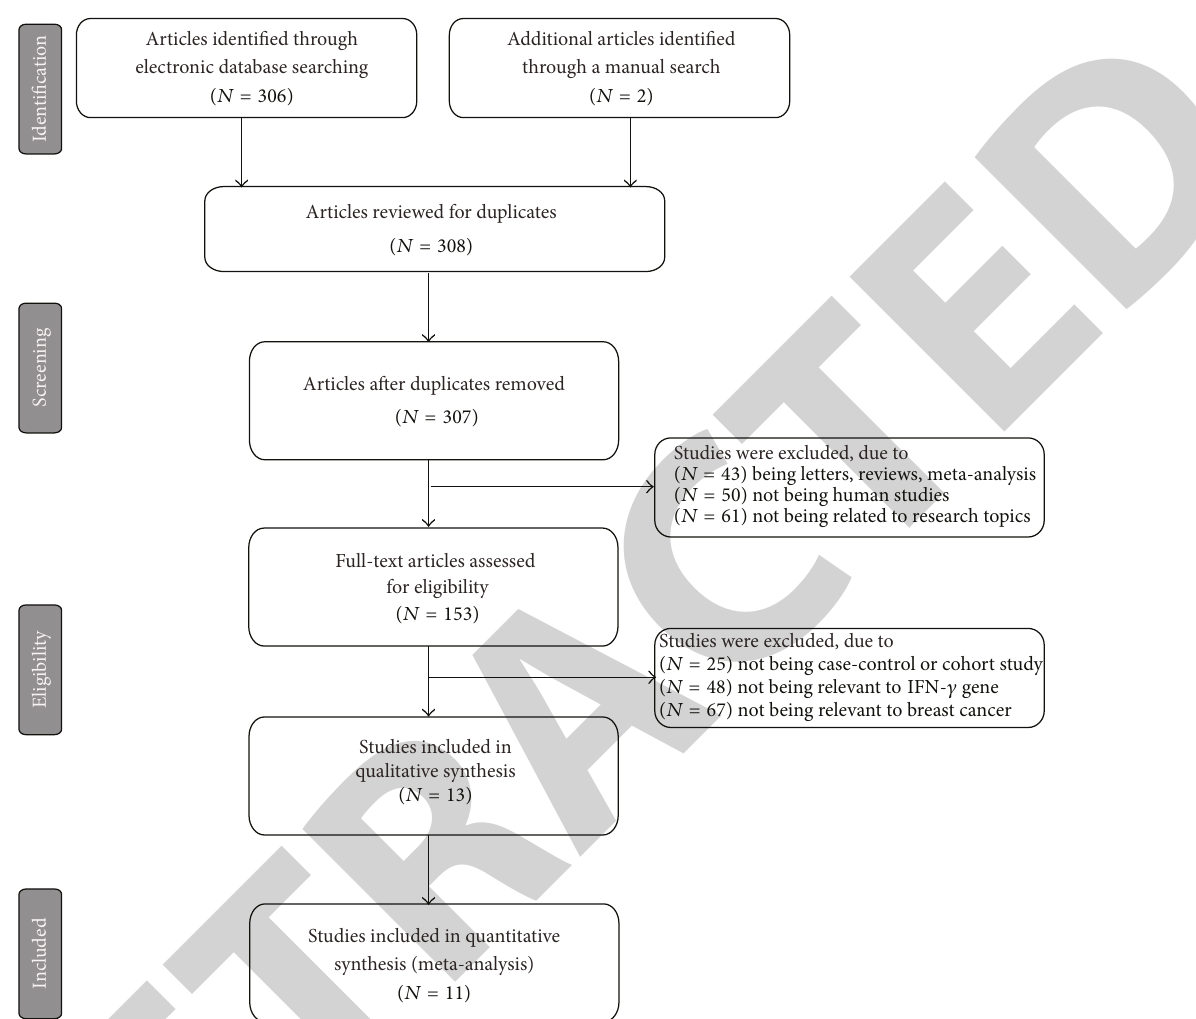
Figure 1: Flow chart of literature search and study selection. Eleven case-control studies were included in this